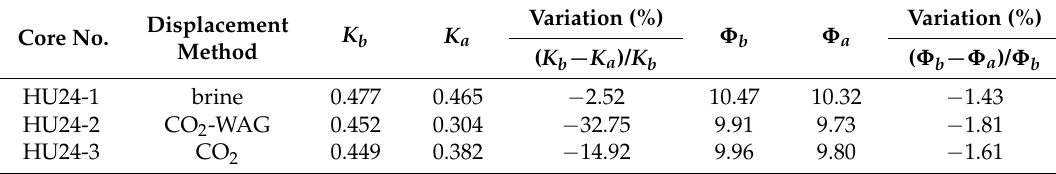
Table 5. Core porosity and permeability before and after the flooding experiments.